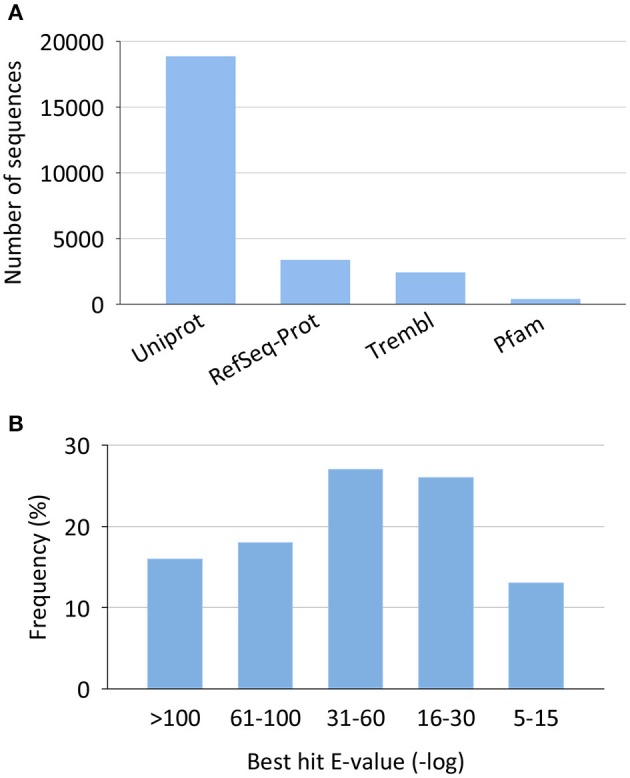
Annotation statistics for the European sea bass transcriptome. (A) Top annotation hits by reference databases. (B) Annotation best hit e-value distribution.